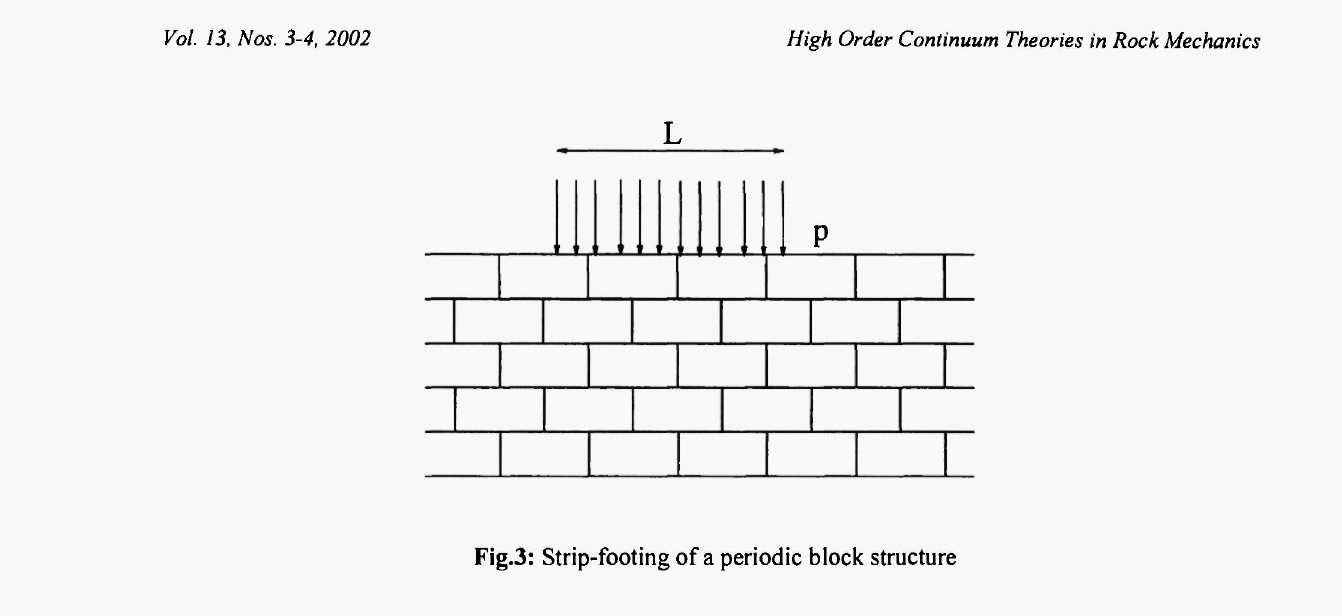
Fig .3: Strip-footing of a periodic block